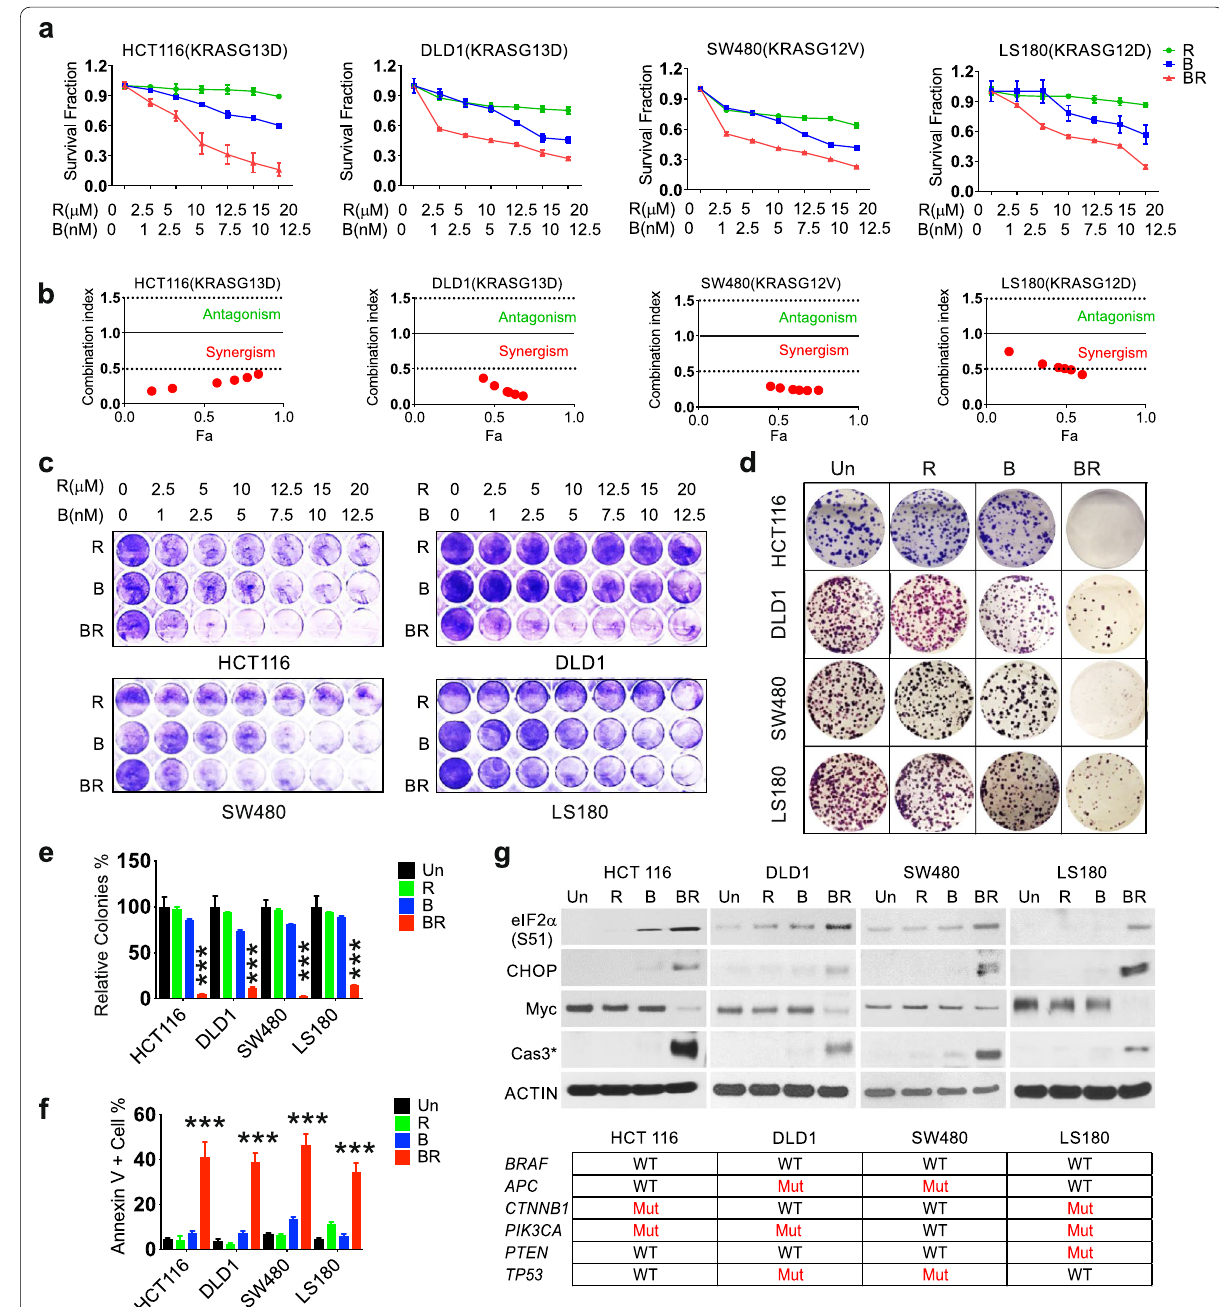
Fig. 1 Bortezomib and Everolimus show synergistic antitumor effects in mutant KRAS CRC cells. Mutant KRAS HCT116, DLD1, SW480 and LS180 cells were treated with vehicle (untreated, Un), Bortezomib (B), Everolimus (R), or their combination (BR, 5 nM and 10 µM or specified ranges). a Cell growth at 48 h was assessed using MTS assay. b Calculated combination index (CI). The CI presents synergism (CI < 1), additive effect (CI 1), = and antagonism (CI > 1). Red area presents synergism, and green area presents antagonism. Fa represents fraction affected. c Attached cells were visualized by crystal violet at 48 h. (D) Colony formation assay. Cells were treated for 24 h and replated in drug free medium for 14 days before crystal violet staining. e The relative number of colonies as in ( d ) was normalized to untreated group (100%). f Apoptosis was quantitated by Annexin V cells using flow cytometry. g Indicated proteins at 24 h was detected using western blotting. ACTIN is used as loading control. The + status of major drivers is shown below. e, f, values are mean s.d. ( n 3). *** p < 0.001 (Student’s t -test, two tailed). B, R vs. + =